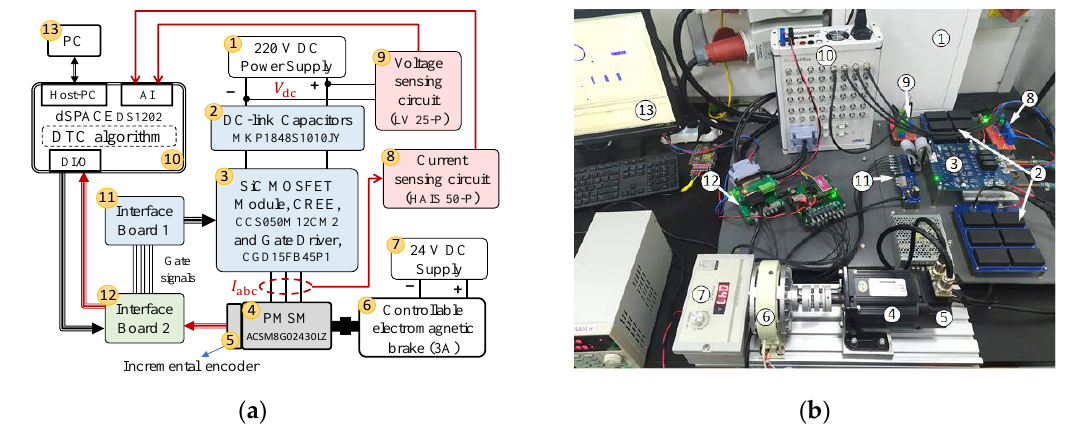
Figure 5. PMSM-based drive system: ( a ) Schematic diagram; ( b ) Experimental setup.